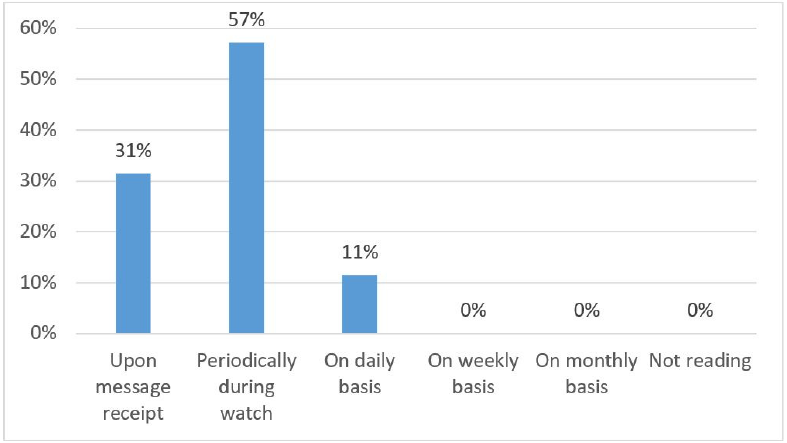
Figure 9. Frequency of use of the Navigational Telex (NAVTEX) receiver.